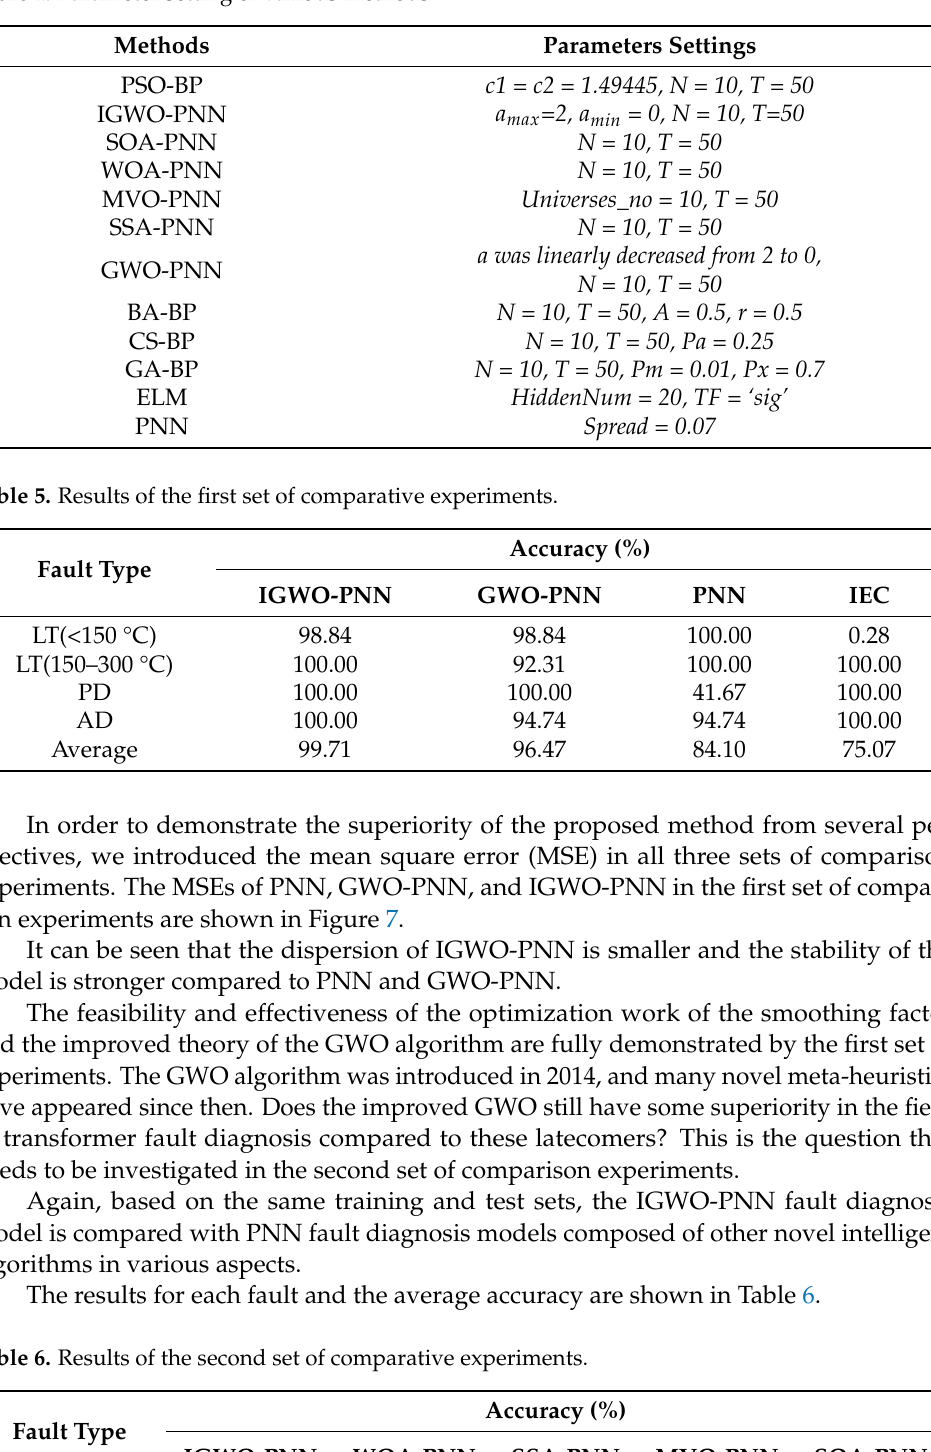
Table 4. Parameter setting of various methods.